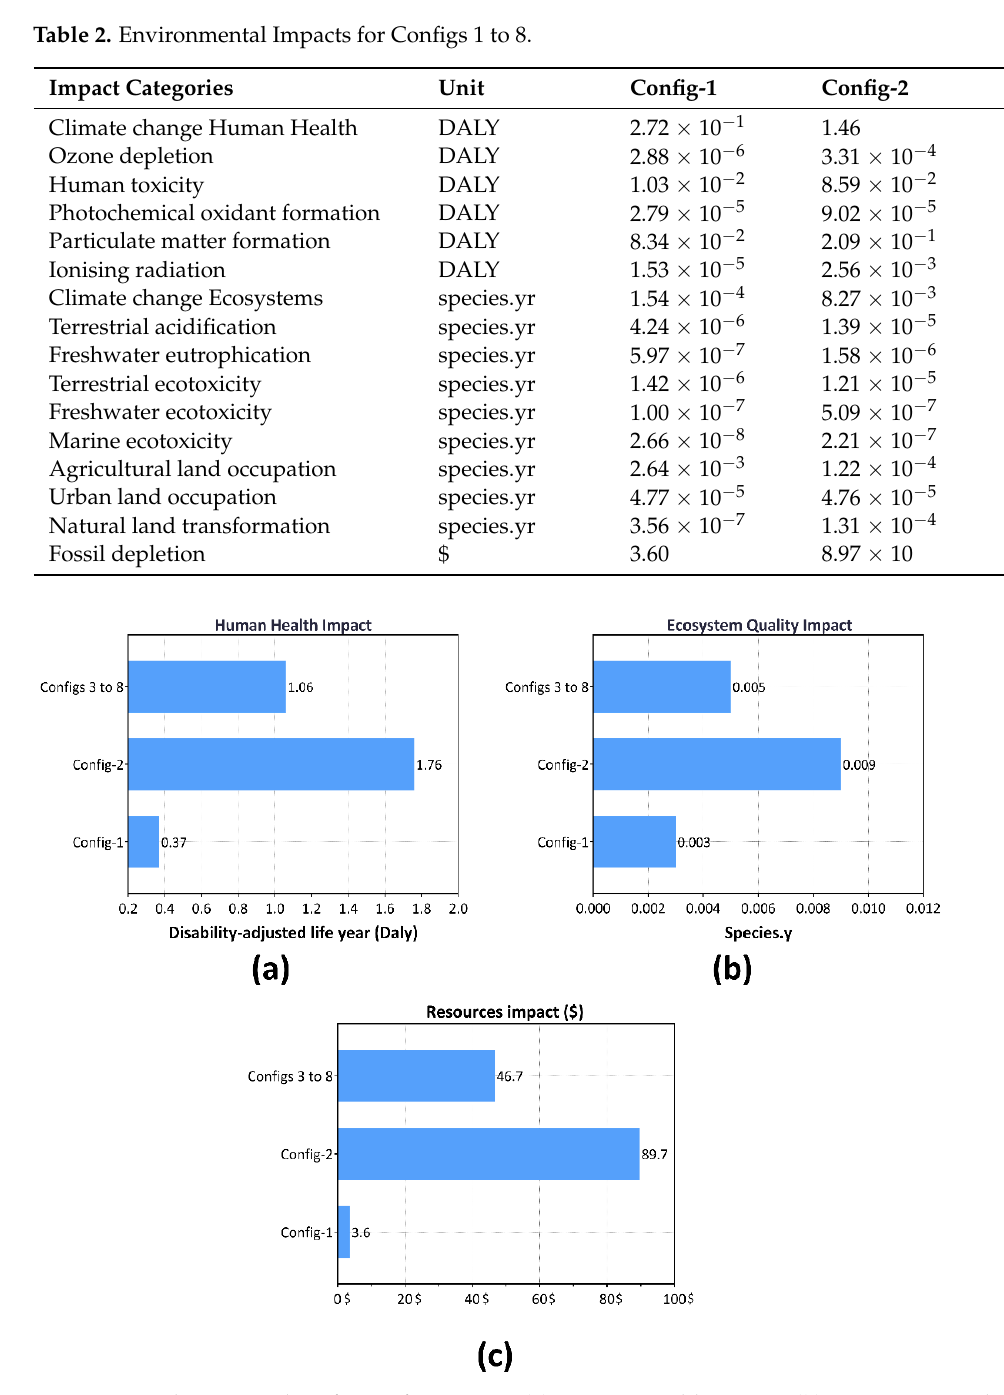
Figure 9. Total impact values for configurations. ( a ) Human Health Impact; ( b ) Ecosystem Quality Impact; ( c ) Resources Impact. The HHI values for Config-1, Config-2, and Configs-3 to 8 are 0.36, 1.76, and 1.06 DALY respectively. Config-1 has 4.8 times less HHI than Config-2 and 2.9 times less HHI than Configs-3 to 8. The EQI values for Config-1, Config-2 and Config-3 to 8 are 0.0028, 0.0086 and 0.0052 species.yr respectively. Config-1 has 3 times less EQI than Config-2 and 1.8 times less EQI than Configs-3 to 8. Finally, the RI values for Config-1, Config-2, and Configs-3 to 8 are $3.6, $89.7, and $46.7, respectively. Config-1 has 24.9 times less RI than Config-2 and 13.97 times less RI than Configs-3 to 8. Config-1 appears to be beneficial for reducing impacts on human health, ecosystem quality, and resources. The reason why the lowest values